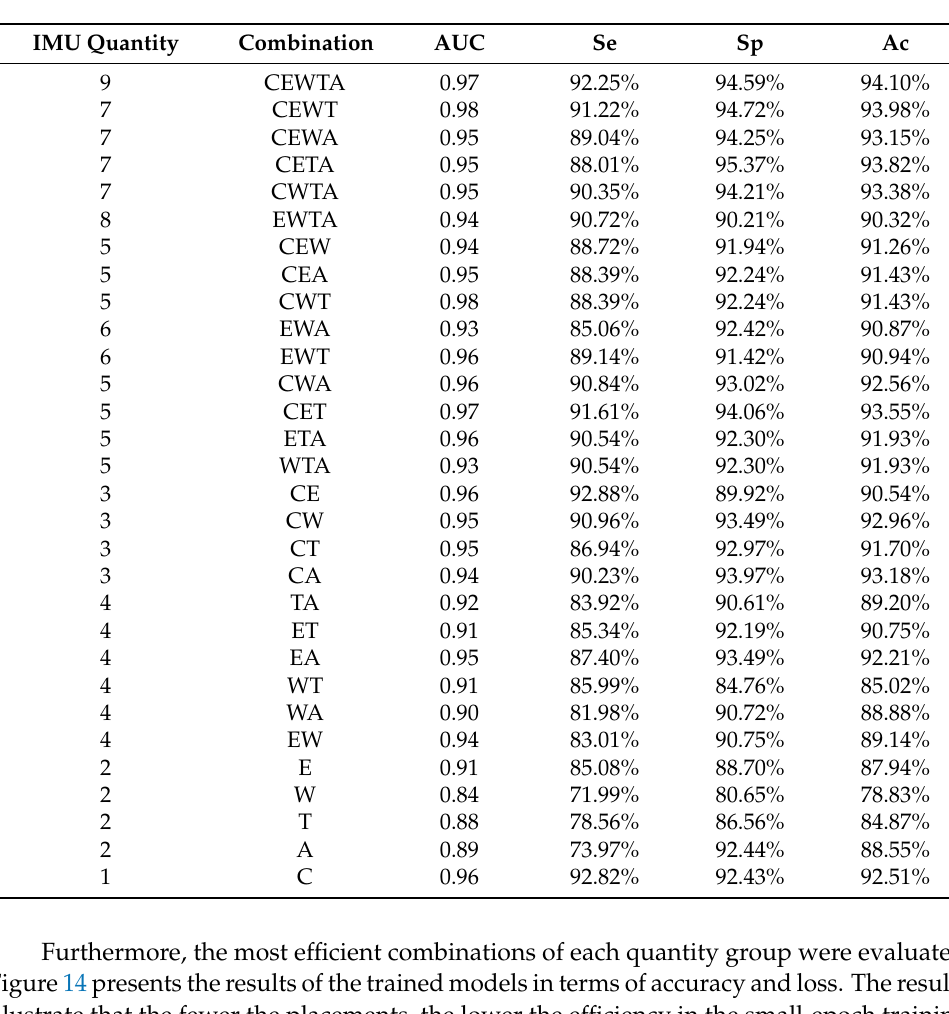
Table 4. Performance of 30 IMU combinations.